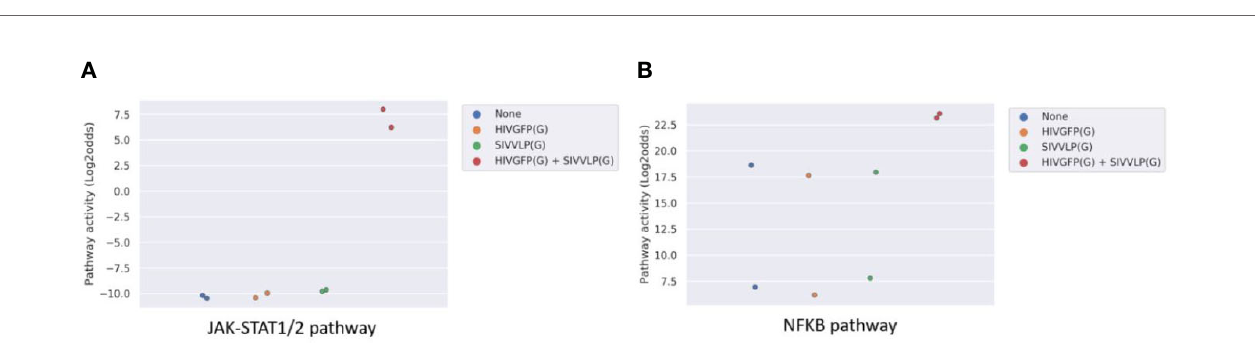
FIGURE 7 | JAK-STAT1/2 (A) and NF k B (B) pathway activity analysis of dataset GSE22589 (46) (n=2): Monocyte-derived dendritic cells (MDDCs) infected with an envelope-defective GFP-encoding VSV-G-pseudotyped HIV-1 vector (HIVGFP(G)) and with VSV-G pseudotyped virus-like particles derived from SIVmac to deliver Vpx (SIVVLP(G)), alone or in combination. Cells were infected with none, one or both vectors at day 4 of differentiation and were harvested 48 h later. Pathway activity score on Y-axis in log2odds.